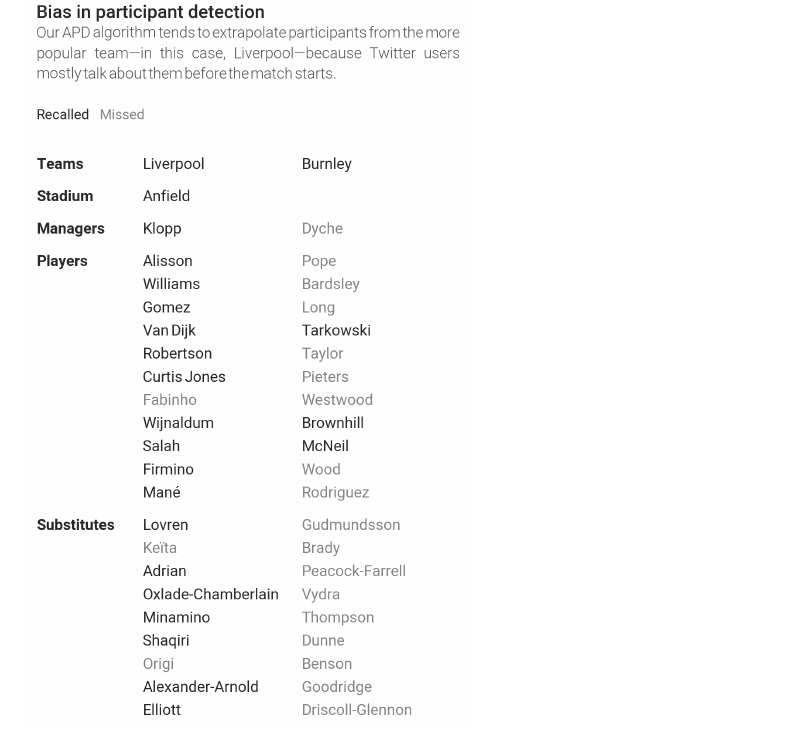
Figure 4. Participant detection inherits Twitter’s bias and predominantly captures participants from the more popular